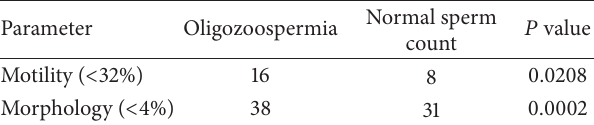
Table 2: Various organisms isolated and their